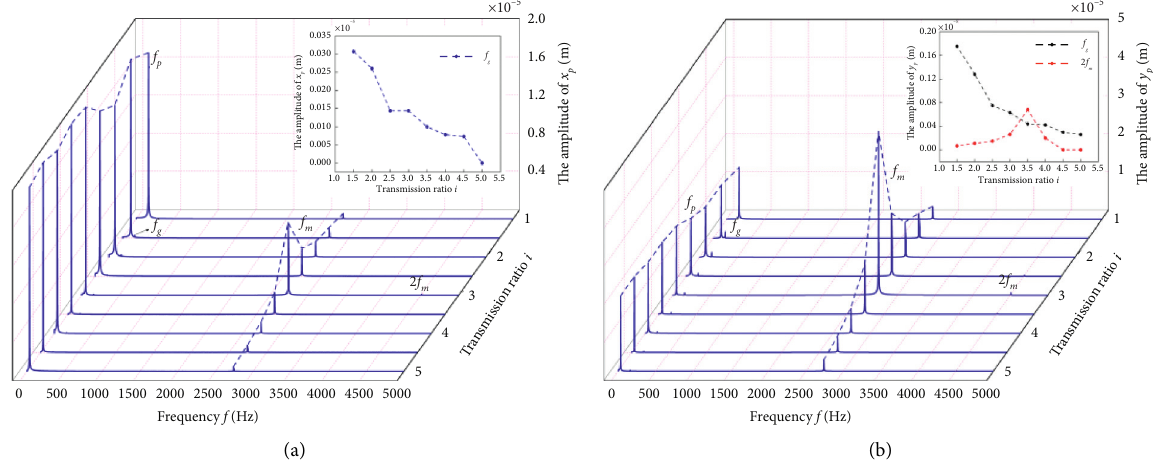
Figure 8: The spectrum waterfall diagram of the driving gear: (a) in x direction and (b) in y direction.